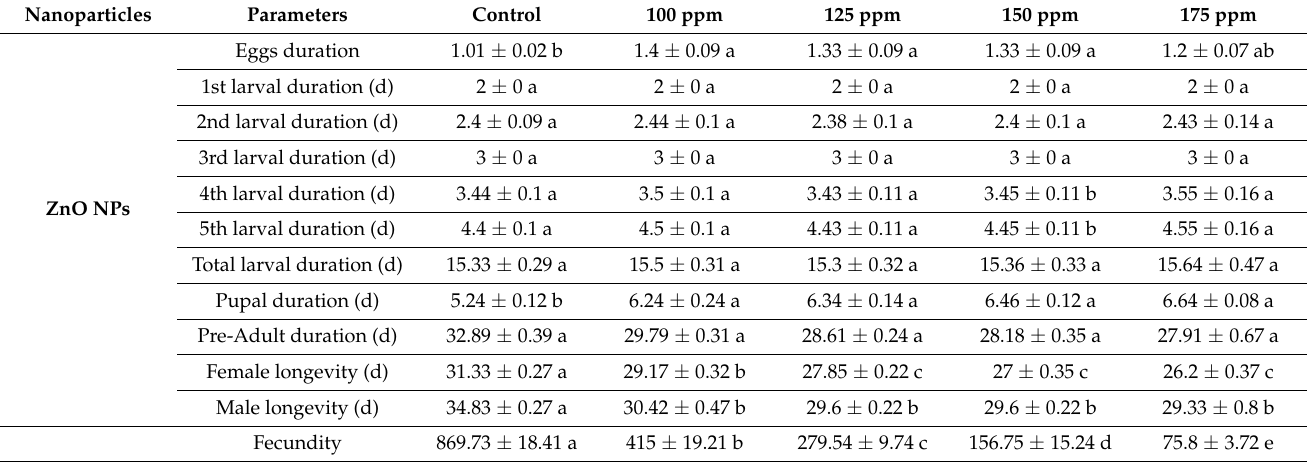
Table 3. Effects of ZnO NPs on biology of H. armigera